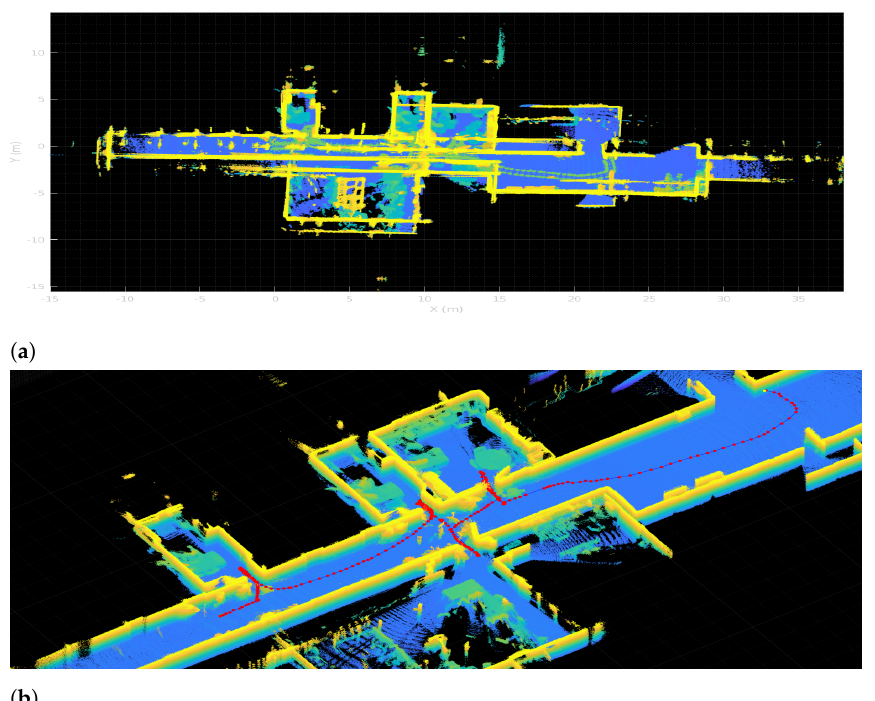
Figure 17. HS-SLAM vs. odometry. ( a ) 3D Robot Odometry map deformation. ( b ) 3D Lidar Odome- try map